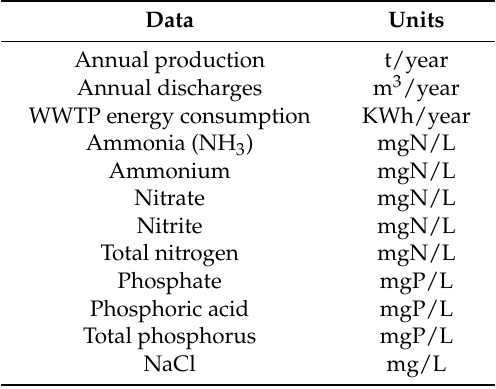
Table 4. Inventory of the data related to the total amount of discharges, energy consumption, and analytical parameters of the final discharges.